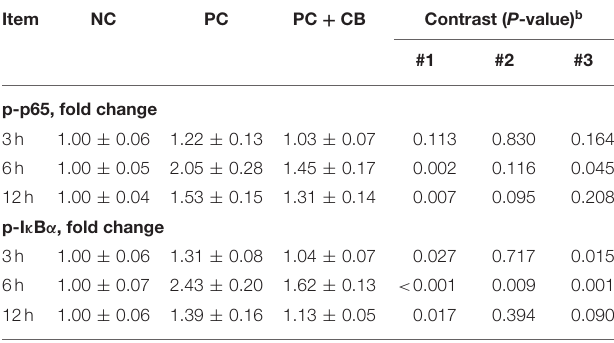
TABLE 5 | Effect of CB on the activation of NF- κ B p65 and I κ B α in ETEC K88-infected piglets a .